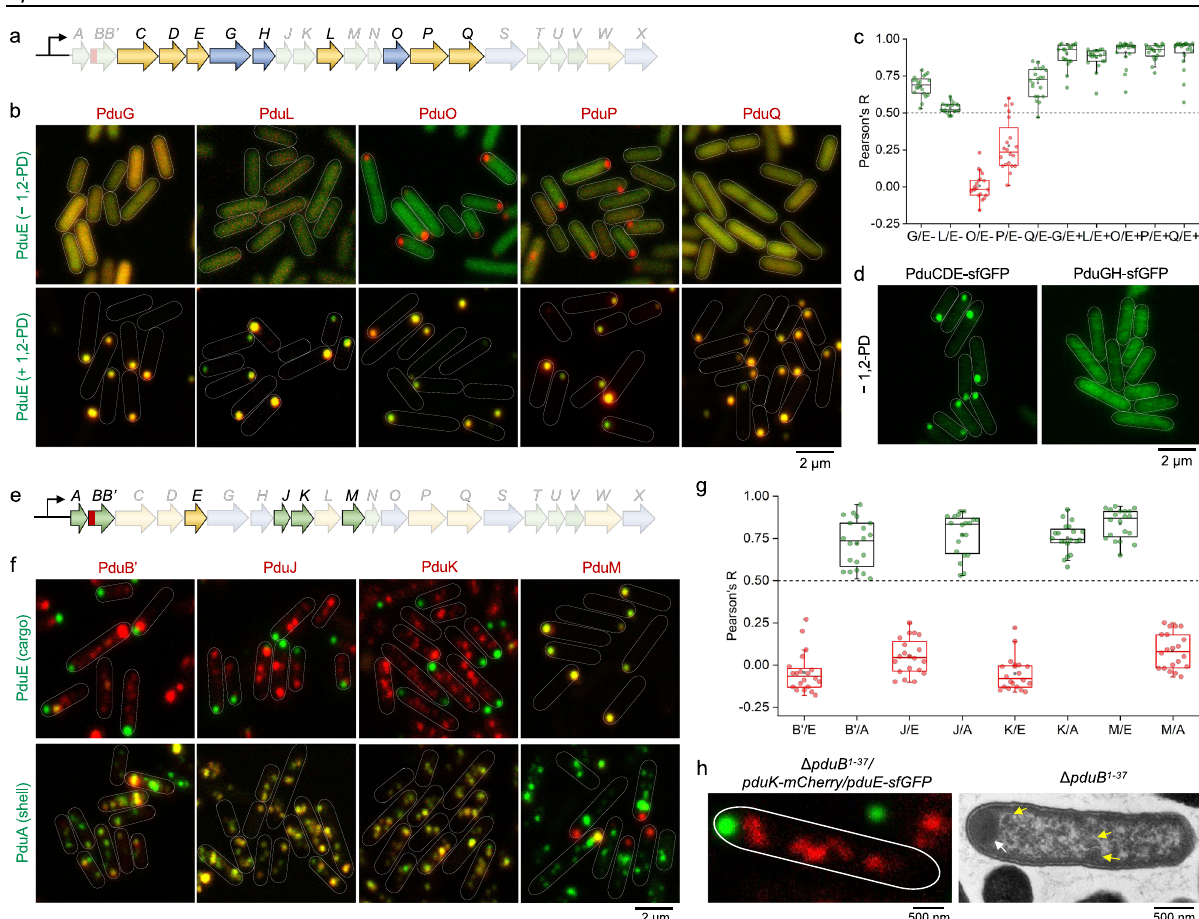
Fig. 3 The PduB N-terminus links between the shell and the enzymatic core. a Relevant cargo-encoding genes of relevance to Fig. 3b – d are highlighted in the context of the pdu operon of S . Typhimurium LT2. b PduE-sfGFP (green) and mCherry (red, labeling different catalytic components) were visualized in Δ pduB 1 – 37 following growth in MIM in the absence and presence of 1,2-PD. c Colocalization analysis of sfGFP and mCherry fl uorescence in ( b ). Note that in panels c , g , the fi rst capital letter of the name refers to the Pdu protein tagged with mCherry and the second capital letter refers to the Pdu protein tagged with sfGFP. “ + ” and “ − “ represent the presence and absence of 1,2-PD, respectively. Pearson ’ s R values for all the strains are: 0.68 ± 0.07 (G/E-); 0.53 ± 0.04 (L/E-); 0.01 ± 0.09 (O/E-); 0.28 ± 0.17 (P/E-); 0.70 ± 0.10 (Q/E-); 0.90 ± 0.08 (G/E + ); 0.87 ± 0.07 (L/E + ); 0.91 ± 0.08 (O/E + ); 0.91 ± 0.05 (P/E + ); 0.91 ± 0.10 (Q/E + ). d The localization PduCDE and PduGH were characterized following growth in MIM-1,2-PD media. e Relevant genes encoding shell and catalytic proteins in f , g . f PduE-sfGFP (green) or PduA-sfGFP (green) and mCherry (red, labeling different structural components) were visualized in Δ pduB 1 – 37 , following growth in MIM + 1,2-PD media. g Colocalization analysis of sfGFP and mCherry fl uorescence in ( f ). The Pearson ’ s R values for all the strains are: − 0.05 ± 0.12 (B ’ /E); 0.72 ± 0.14 (B ’ /A); 0.05 ± 0.10 (J/E); 0.77 ± 0.12 (J/A); − 0.05 ± 0.10 (K/E); 0.75 ± 0.08 (K/A); 0.84 ± 0.09 (M/E); 0.08 ± 0.10 (M/A). h Microscopic characterization of the Δ pduB 1 – 37 strain following growth in MIM + 1,2-PD media, showing a polar enzymatic core and several empty shell structures (arrows). Note: In c , g , data are represented as mean ± SD. n = 20, n represents the number of cells. Boxplot center lines correspond to the median value, and upper and lower whiskers extend from the box to the largest or smallest value correspondingly, but no more than 1.5 times the interquartile range; mean values show as the square